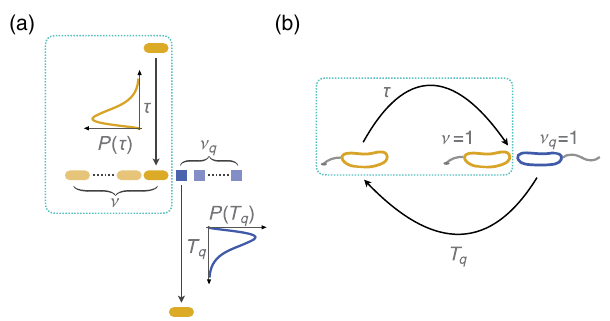
FIG. 1. Schematic representation of model and experimental system. In (a), we summarize the general model considered. Upon division, a normal (yellow) cell divides into ν normal cells and ν reproductively quiescent (blue) cells. Division occurs after q a stochastic waiting time τ , drawn from a distribution P ð τ Þ . The quiescent cells transition into normal cells with a waiting-time ð T Þ . Model specification requires knowledge of distribution P q q ν , ν ð T Þ . By setting ν ¼ 0 , one obtains a model , P ð τ Þ , and P q q q q of symmetric division (dotted cyan box). In (b), we show a schematic of the relevant timescales in the C. crescentus life cycle: the stalked (normal) cell division time τ and the swarmer (quiescent) cell to stalked cell transition time T . Upon division, a q stalked cell gives birth to a stalked and a swarmer cell. Thus, the C. crescentus cell cycle reduces to the model in (a) with ν ¼ ν ¼ 1 . The single-cell technology introduced in Ref. [2] q ¼ 0 (dotted cyan corresponds to a model with ν ¼ 1 and ν q